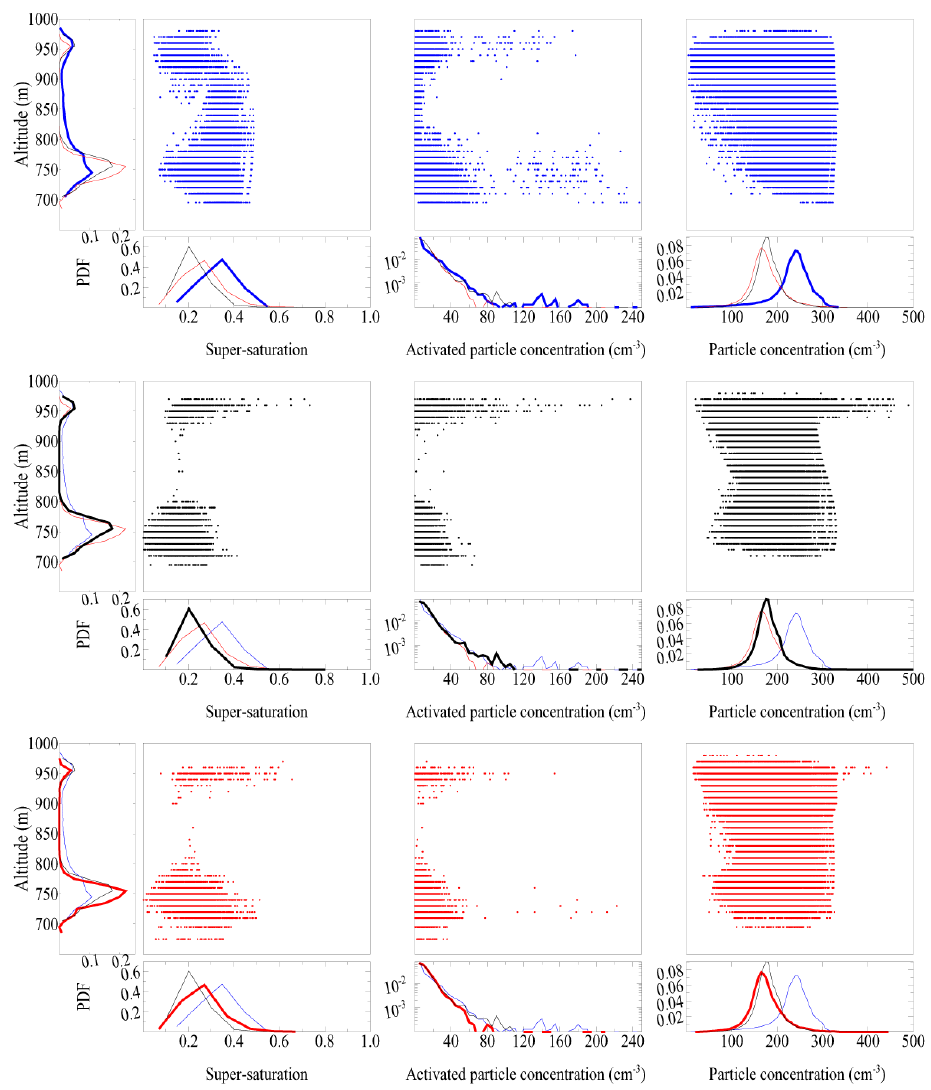
Fig. 3. For the DRY case: vertical distribution of supersaturation values in model grid boxes where CCN activation occurs (left), number concentration of activated particles, N act , during the time step (middle) and resulting number concentration of cloud droplets, N c , in all cloudy grid boxes (right) with the A (top-blue), B (middle line-black) and C (bottom-red) schemes. The far left graph shows the PDF of occurrence of activation events in the vertical, while the ones under each figure are for the PDF of parameter